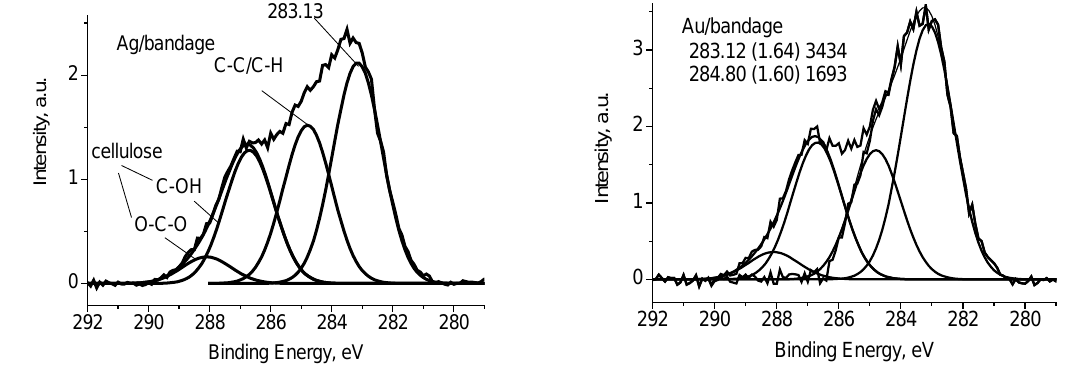
Figure 10. The C 1s photoelectron spectra of Ag/bandage and Au/bandage systems.